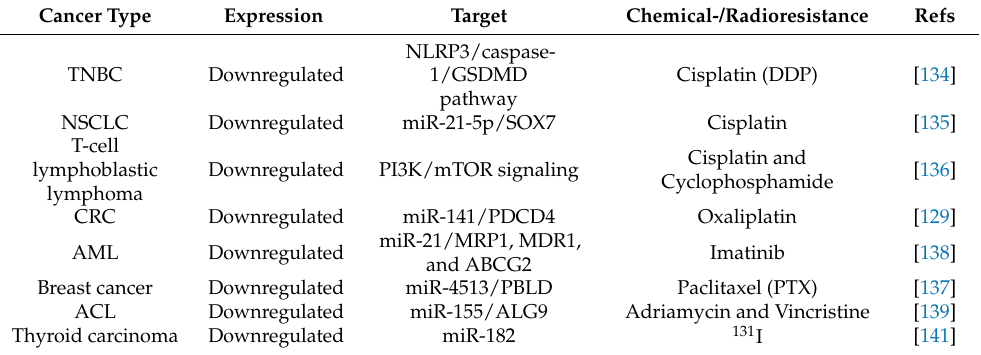
Table 3. Roles of MEG3 in therapeutic resistance of